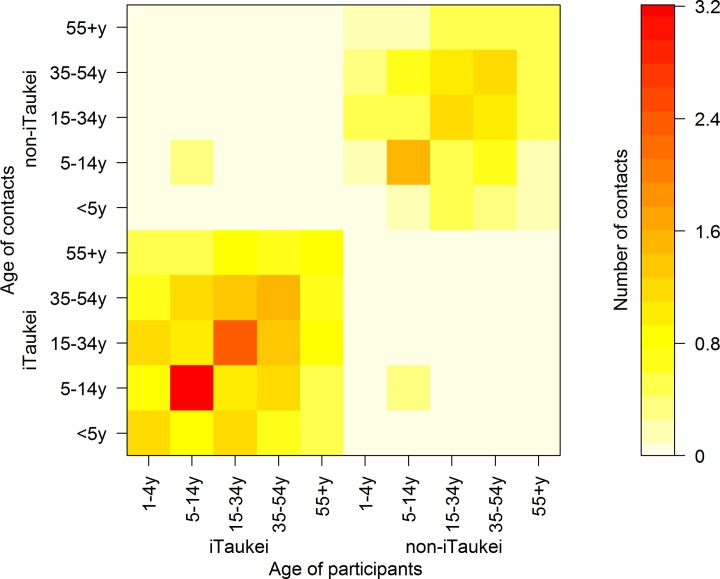
Age and ethnicity structured mixing matrices of reciprocity-weighted unique mealtime contacts per day.